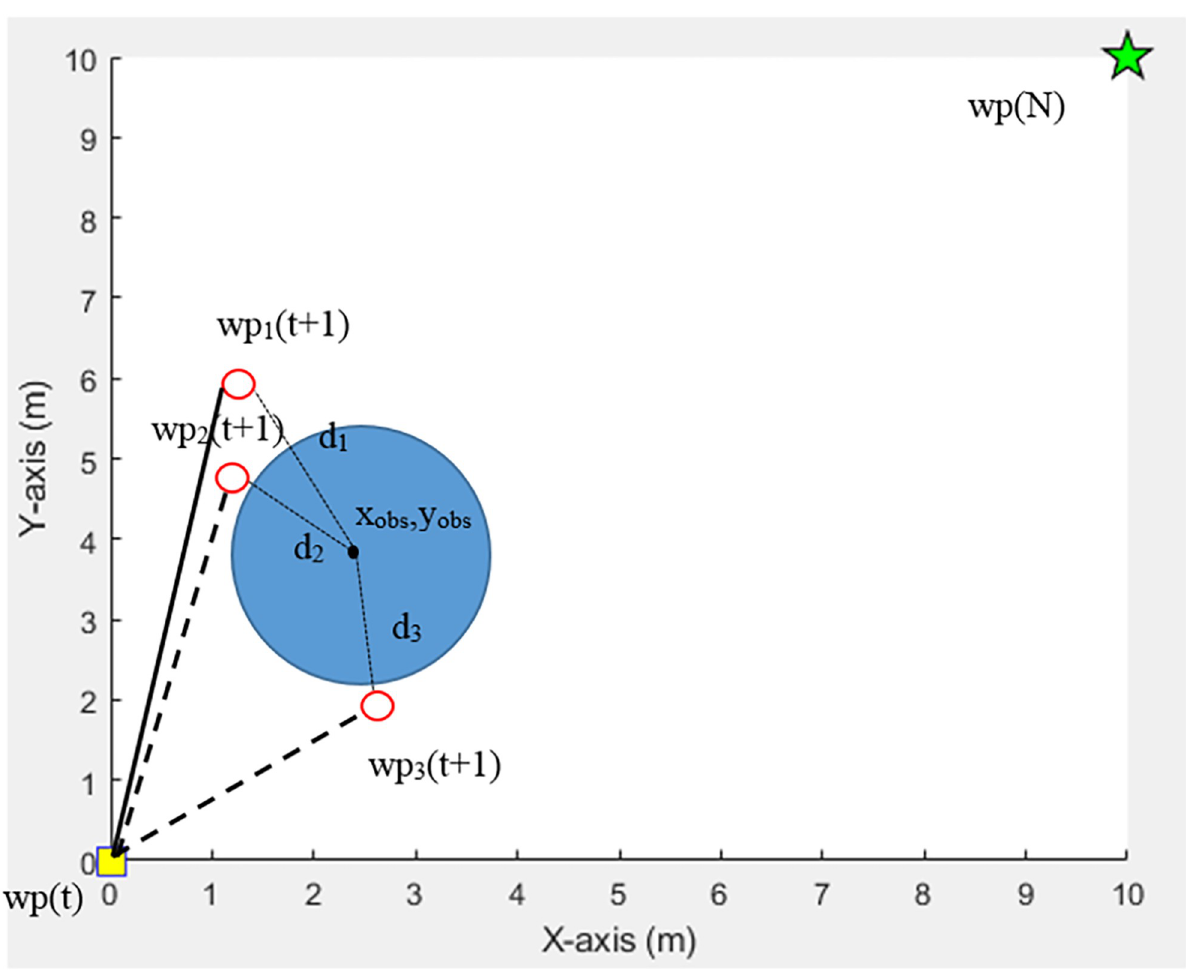
Fig 7. Consideration of safe